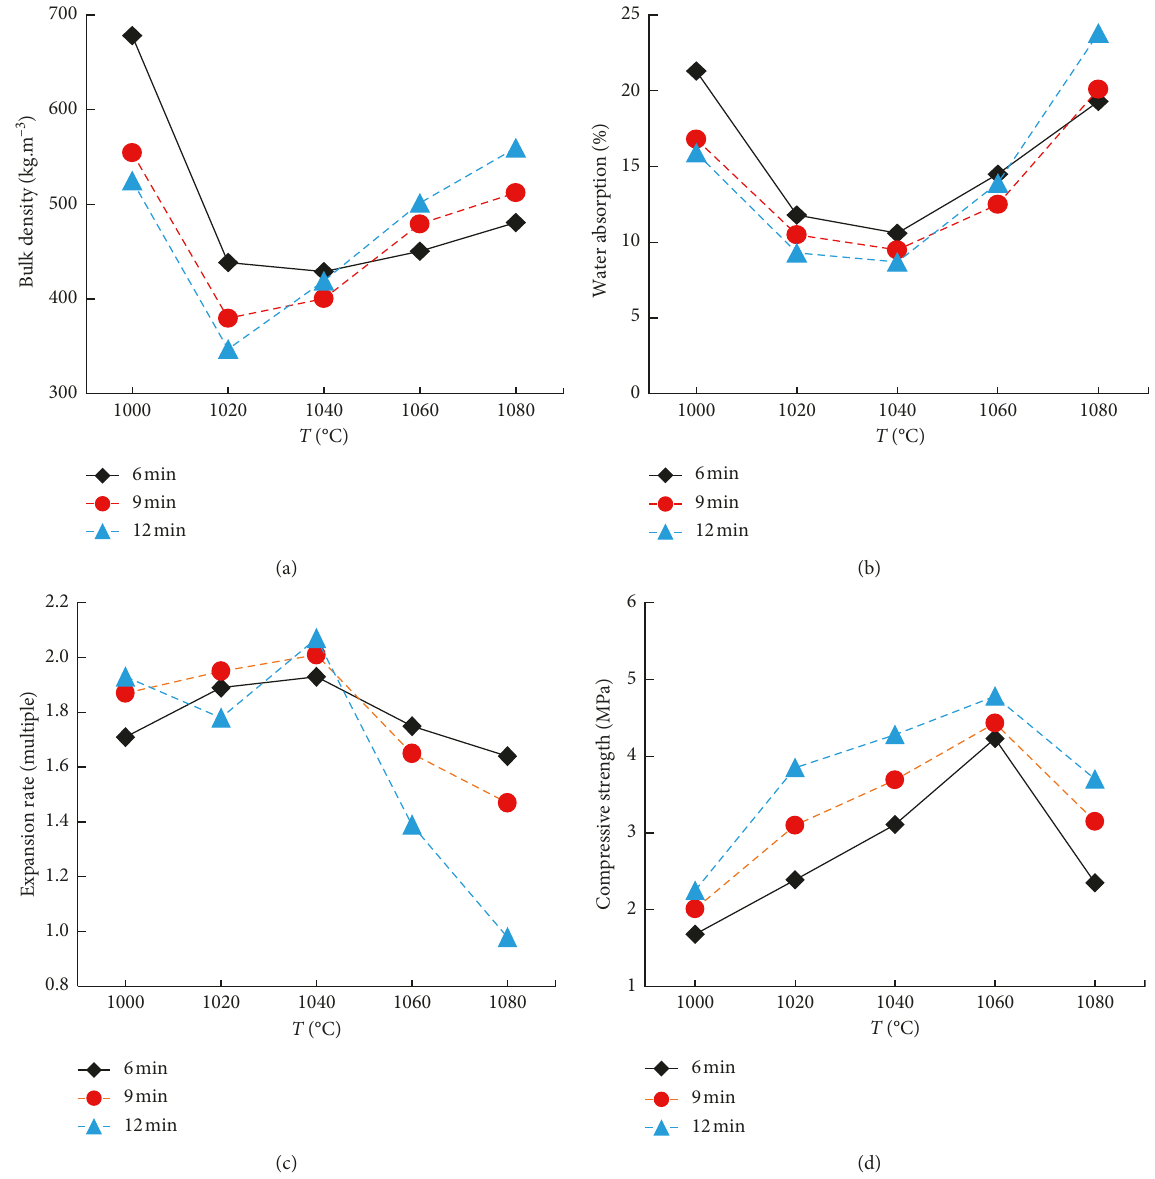
Figure 4: Effect of the sintering system on the performance of marine clay ceramic. (a) Bulk density-temperature curve; (b) water ab- sorption-temperature curve; (c) expansion rate-temperature curve; (d) compressive strength-temperature